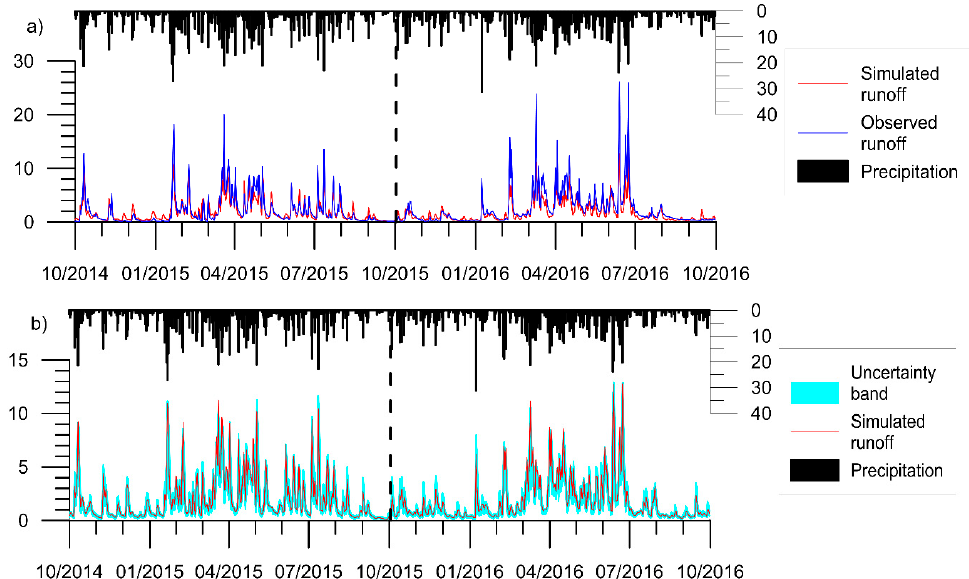
Figure 3. ( a ) Best simulated (according to NSeff) runoff for the subcatchment S8 (Zhurucay catchment)